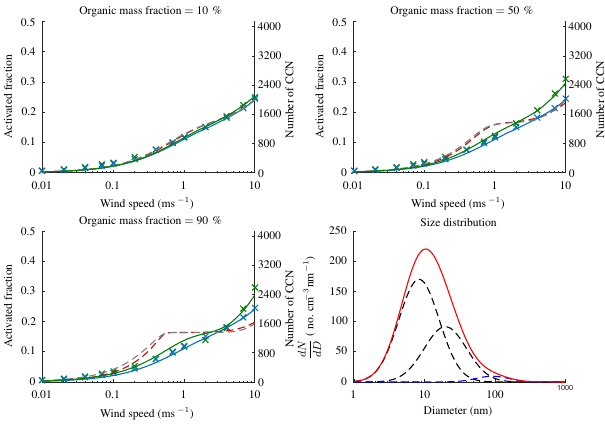
Figure 9. Same as Fig. 7 for the near-city environment.